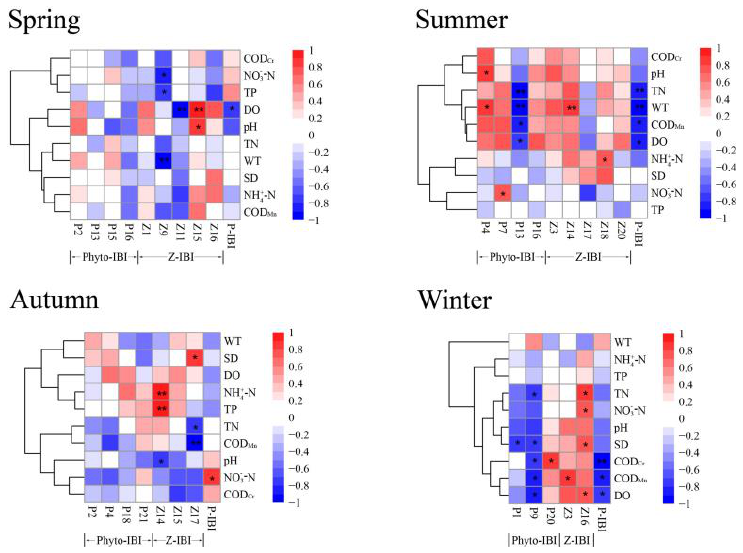
Figure 6. Heatmap of correlations between P–IBI metrics and environmental factors. Note: * p < 0.05 level; ** p < 0.01.